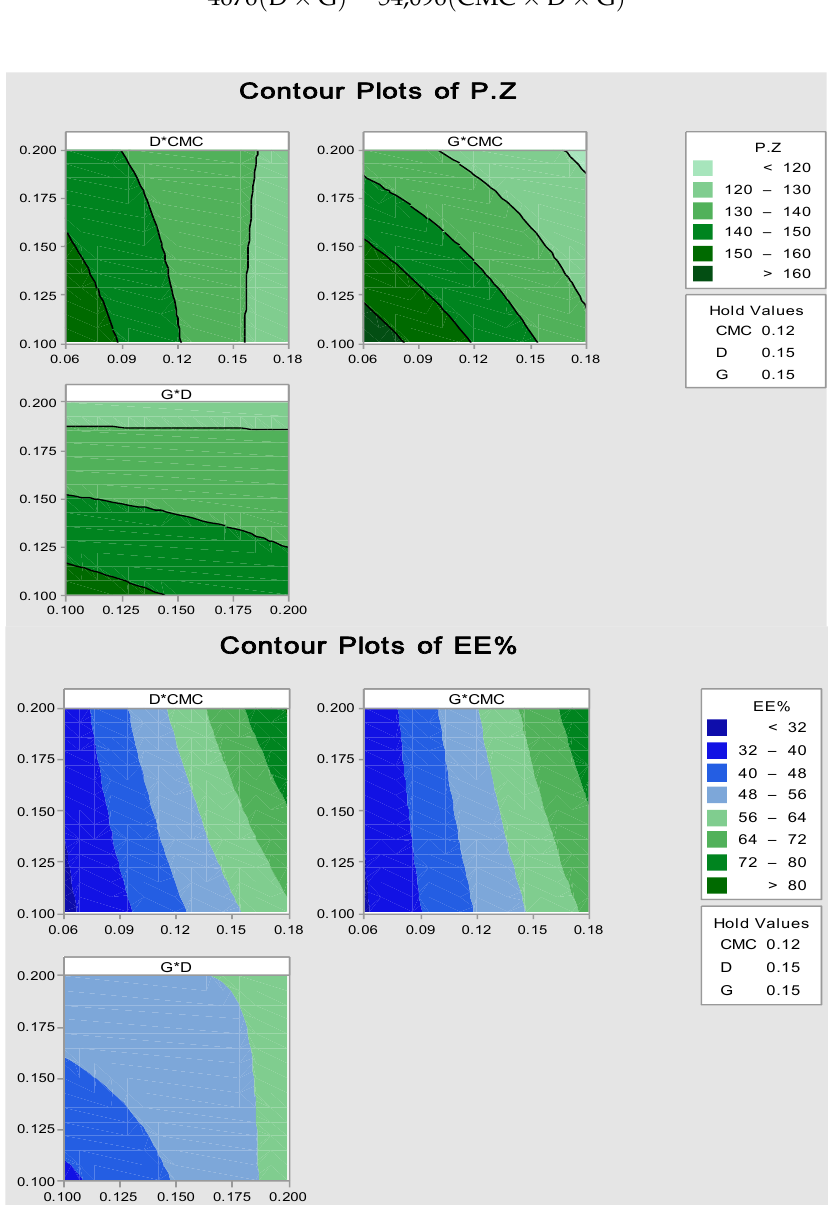
Figure 1. Contour plots of particle size (P.Z) and EE% (the X and Y axes present different amount of independent variable such as concentration of ciprofloxacin (D), concentration of ginsenoside R-g3 (G) and concentration of surfactant (CMC)).